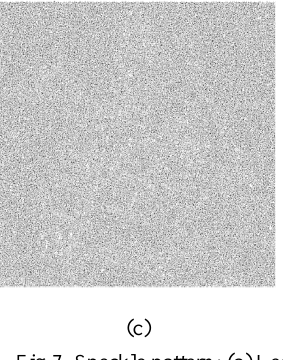
Fig 7. Speckle pattern: (a) Lee filter, (b) Gamma MAP filter, (c) Our